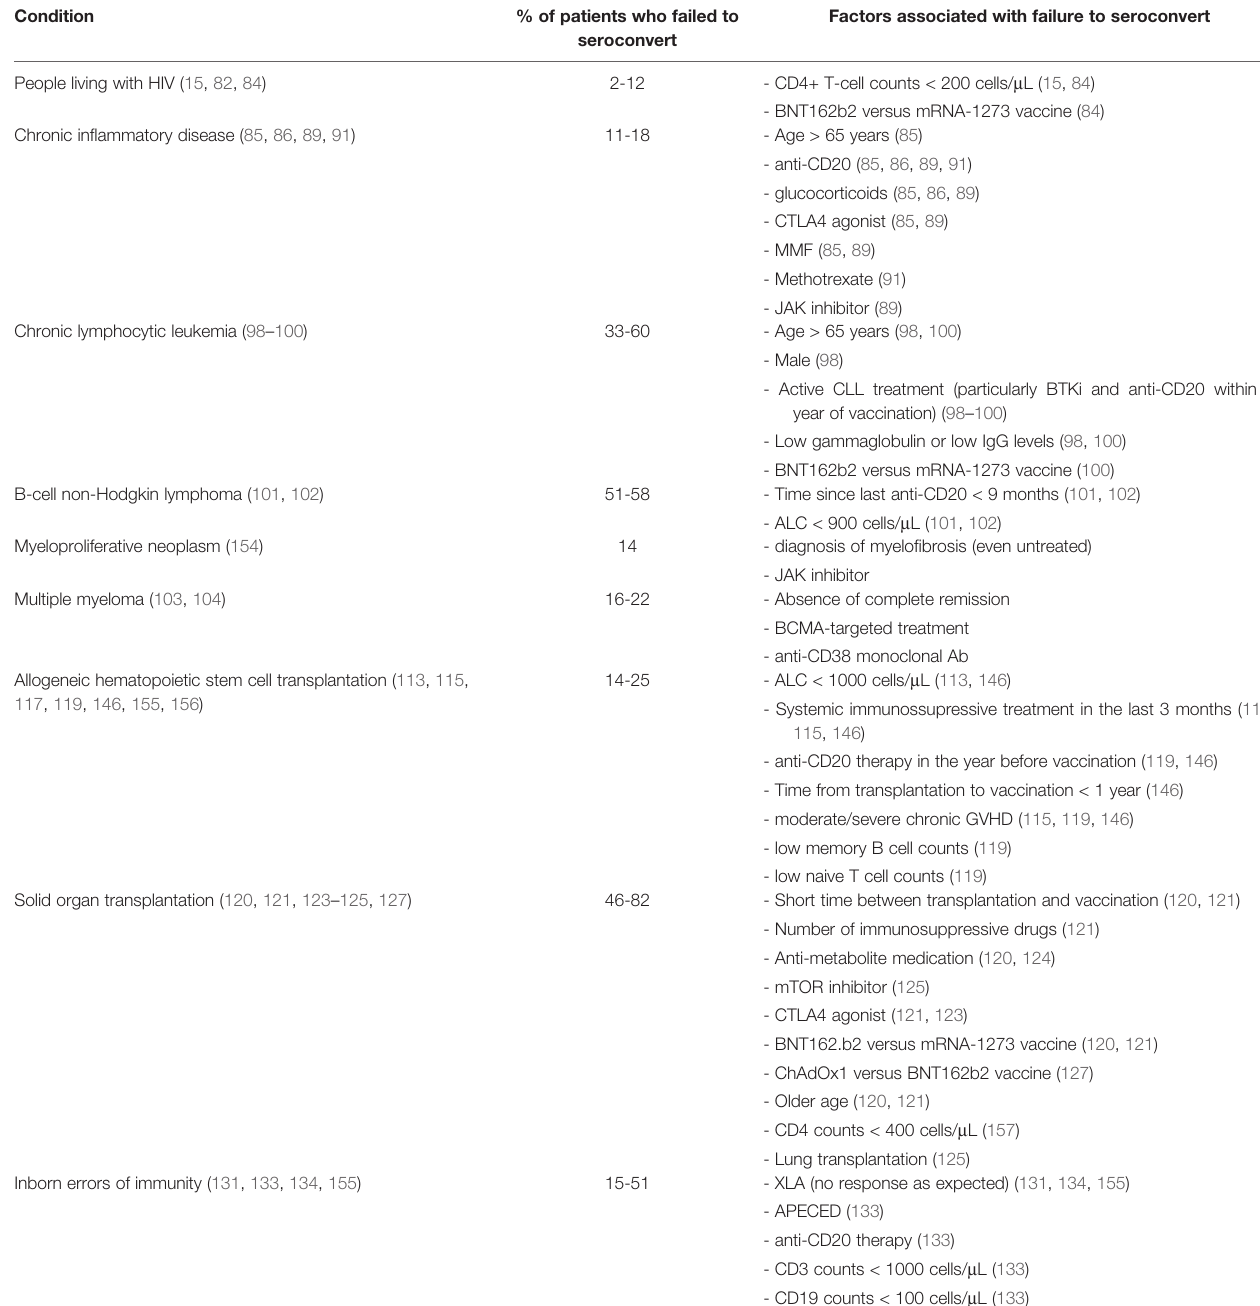
Factors associated with failure to seroconvert seroconvert